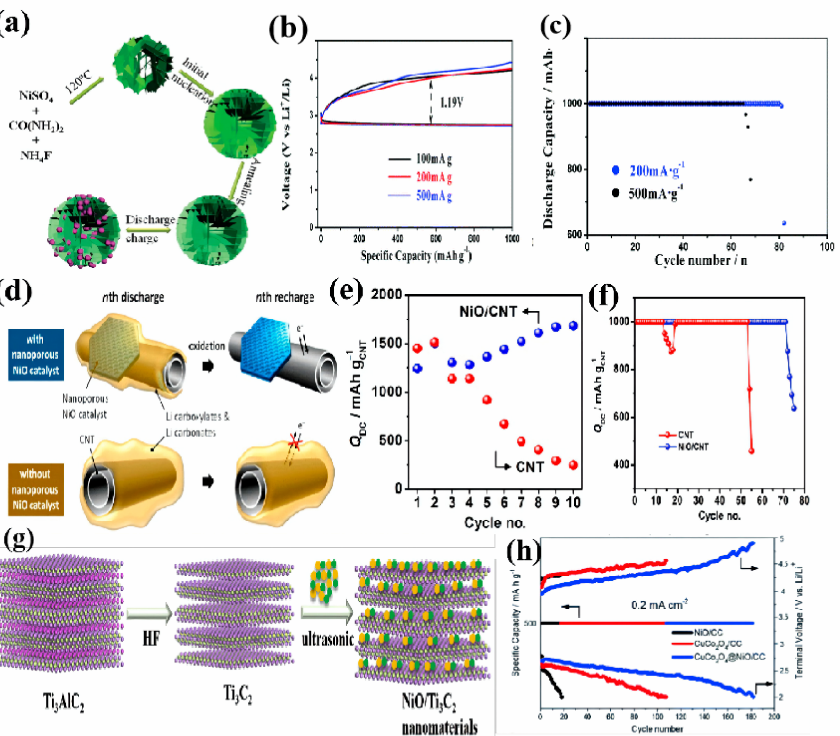
Figure 8. ( a ) Simple synthesis of flower like NiO and its application in rechargeable lithium oxygen batteries. ( b , c ) discharge/charge curve of NiO cathode lithium oxygen battery cycle performance under different current densities at 200 and 500 mA g − 1 with a fixed capacity of 1000 mA h g − 1 . Reprinted with permission from ref. [98]. Copyright 2016 Royal Society of Chemistry. ( d ) Schematic diagram of carbonate/carboxylate decomposition of CNT and NiO/CNT catalyst electrodes. ( e ) Full discharge capacity retention of NiO/CNT and CNT electrodes with different cycle times at 0.1 mA cm − 2 current rate. ( f ) Discharge capacity retention of NiO/CNT (blue) and CNT (red) with a cut-off capacity of 1000 mA h g − 1 at 250 mA g − 1 . Reprinted with permission from ref. [101]. Copyright 2015 American Chemical Society. ( g ) Schematic diagram describing the synthesis process of NiO/Ti 3 C 2 nanomaterials. Reprinted with permission from ref. [104]. Copyright 2020 Elsevier. ( h ) cycle performance of NiO/CC, CuCo 2 O 4 /CC and CuCo 2 O 4 @NiO/CC. Reprinted with permission from ref. [103]. Copyright 2021 Royal Society of